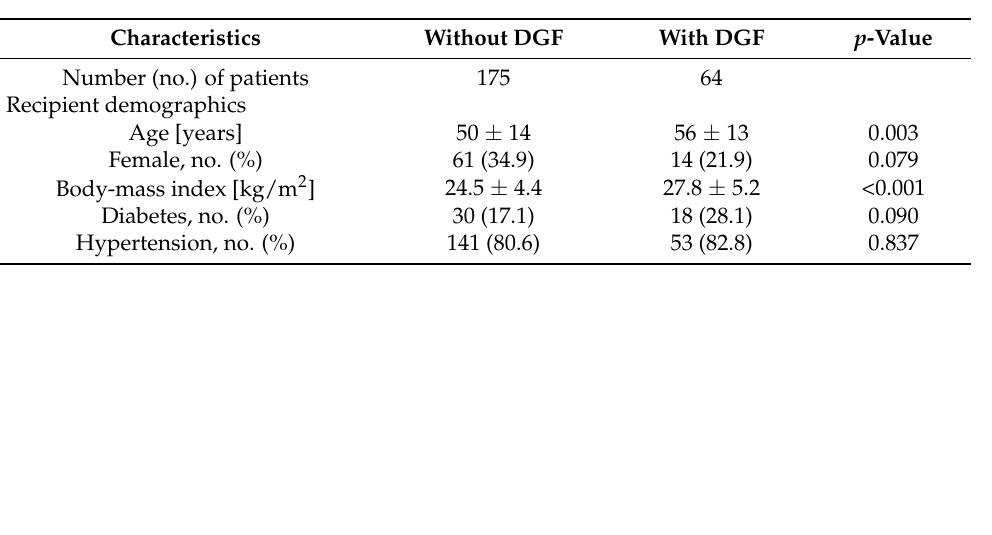
Table 2. Baseline characteristics of participants stratified by status regarding delayed graft func- tion